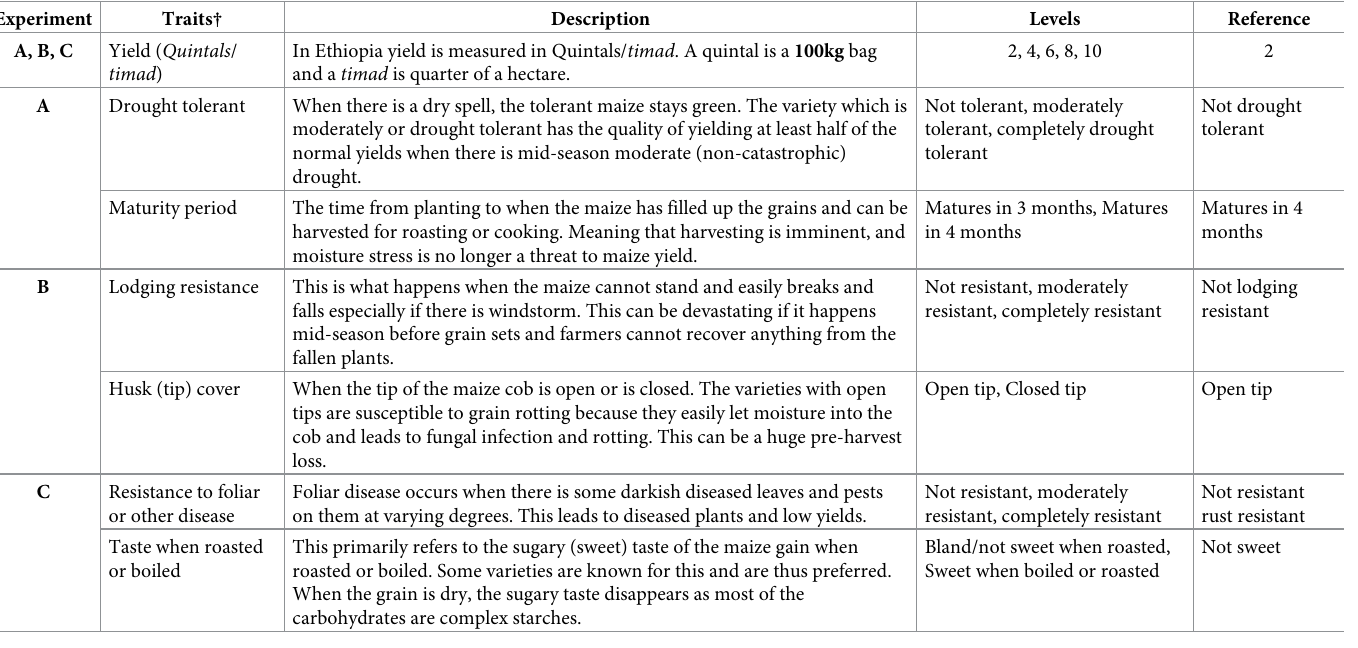
Table 3. Summary of maize traits identified and used in the